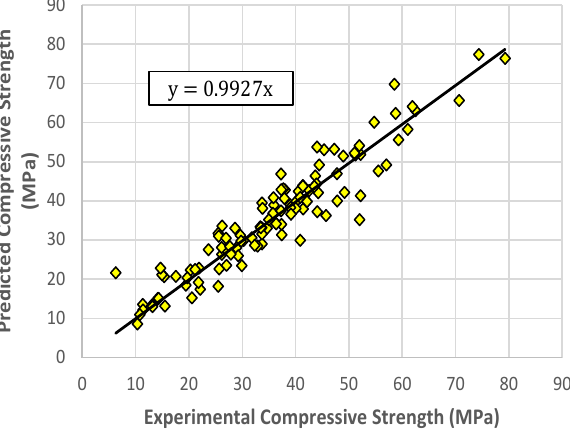
Figure 8. Predicted versus experimental compressive strength values, RELM model for testing data.